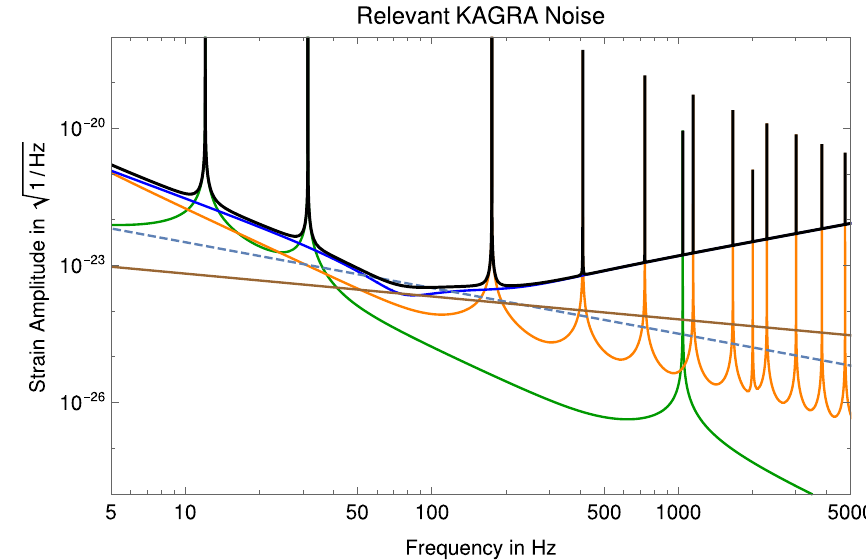
Fig. 2 Overview of strain amplitudes of relevant noise components in KAGRA. The green (orange) line is the vertical (horizontal) suspension thermal noise. The KAGRA quantum noise is shown as blue line and the SQL is shown for comparison as light blue, dashed line. The mirror thermal noise is the brown line. The total noise is the black